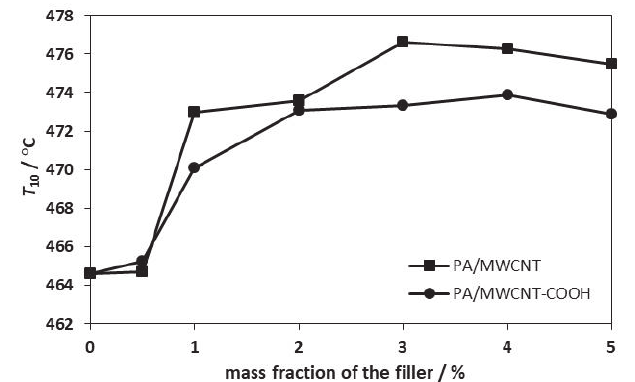
Fig. 8 – Influence of mass fraction of filler on offset tempera- ture (90 % of mass loss) for PA/MWCNT and PA/ MWCNT-COOH